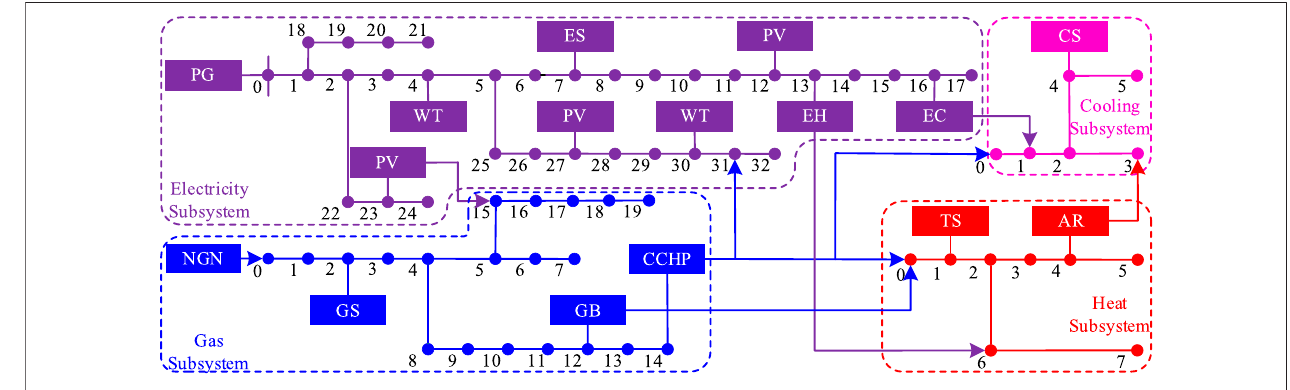
FIGURE 1 | Grid structure of the electricity-heat-cooling-gas IES.